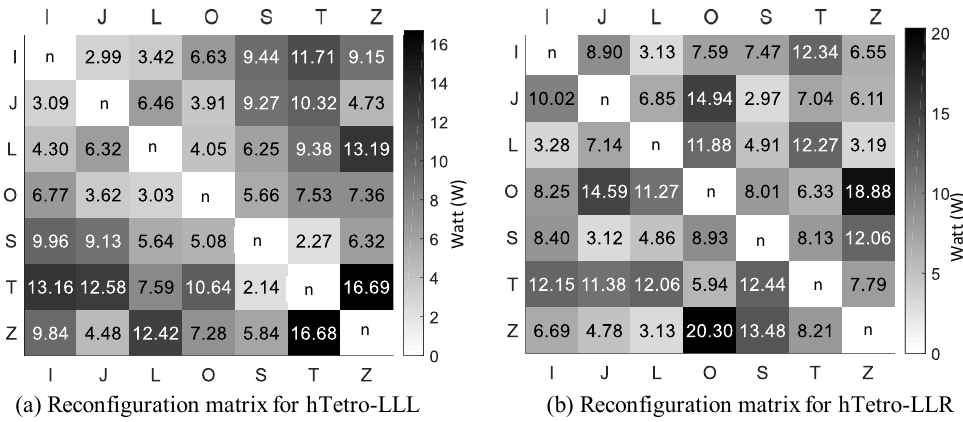
Figure 12. Power consumption during reconfiguration in experiment from one finite state to another in hTetro-LLL and